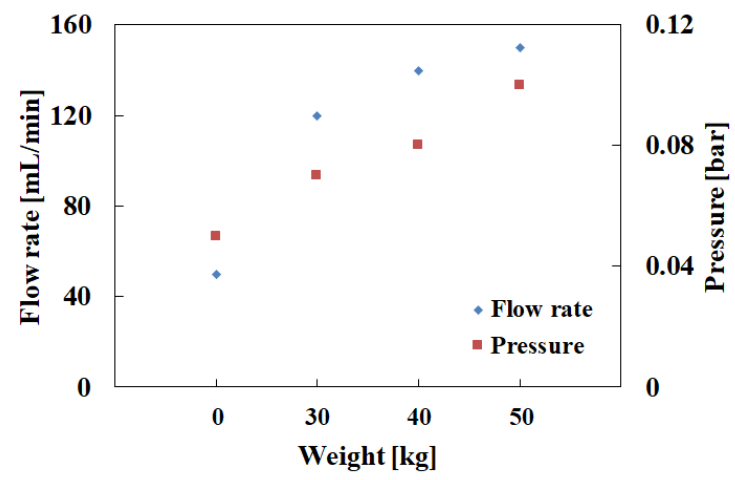
Figure 4. Variations of flow rate and pressure with various loads.